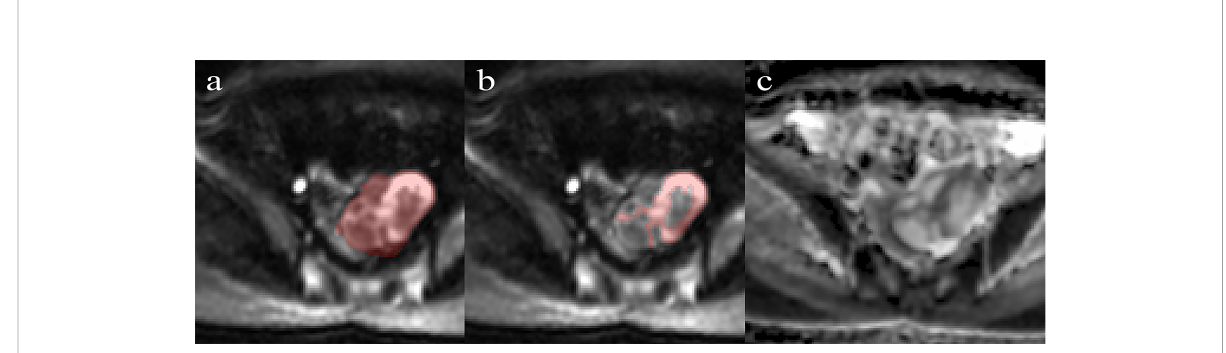
FIGURE 1 Performance of region of interest on the DWI ( b = 1000 s/mm 2 ) by referring to T2WI. (A) Whole-tumor ROIs are manually drawn along the edge of the tumor on the DWI. (B) Solid-tumor ROIs are drawn along the solid components of the tumor. (C) The corresponding ADC